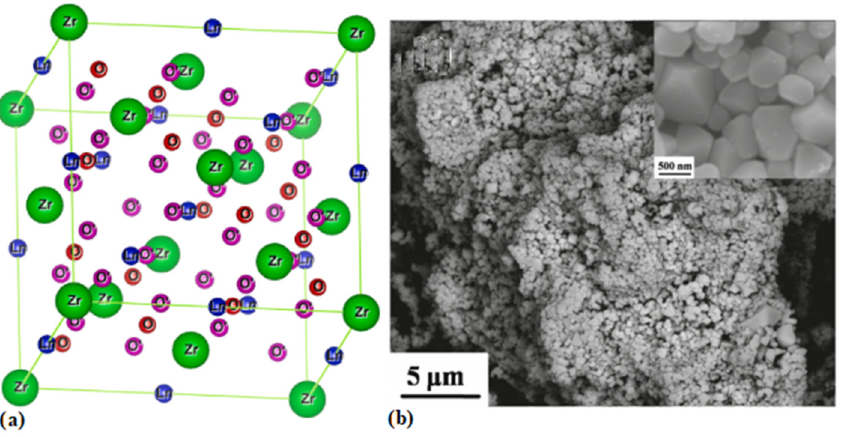
Figure 3. ( a ) Illustration of the La 2 Cr 2 O 7 [32] (Permission from [32] Copyright 2021 Elsevier), ( b ) SEM micrographs of La 2 Cr 2 O 7 at high temperature [33] (Permission from [33] Copyright 2016 Else- vier).